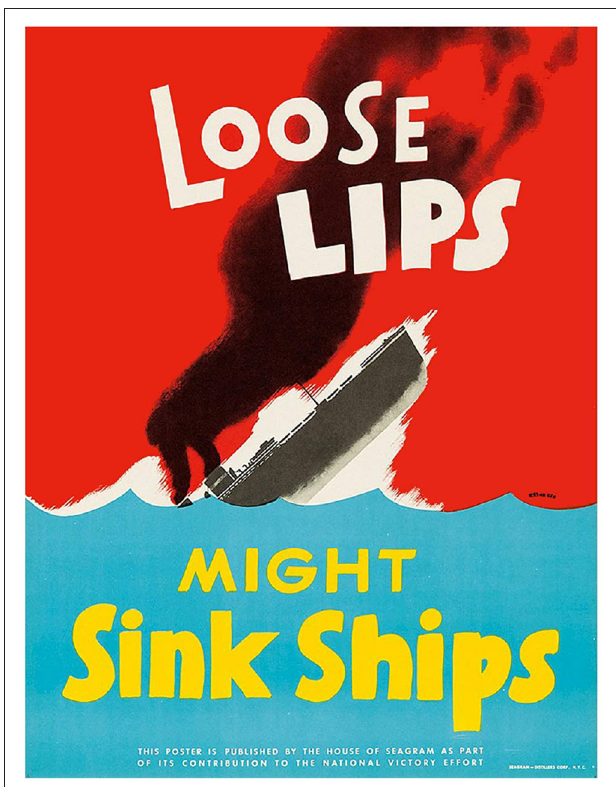
FIGURE 6 | World War Two US internal Propaganda